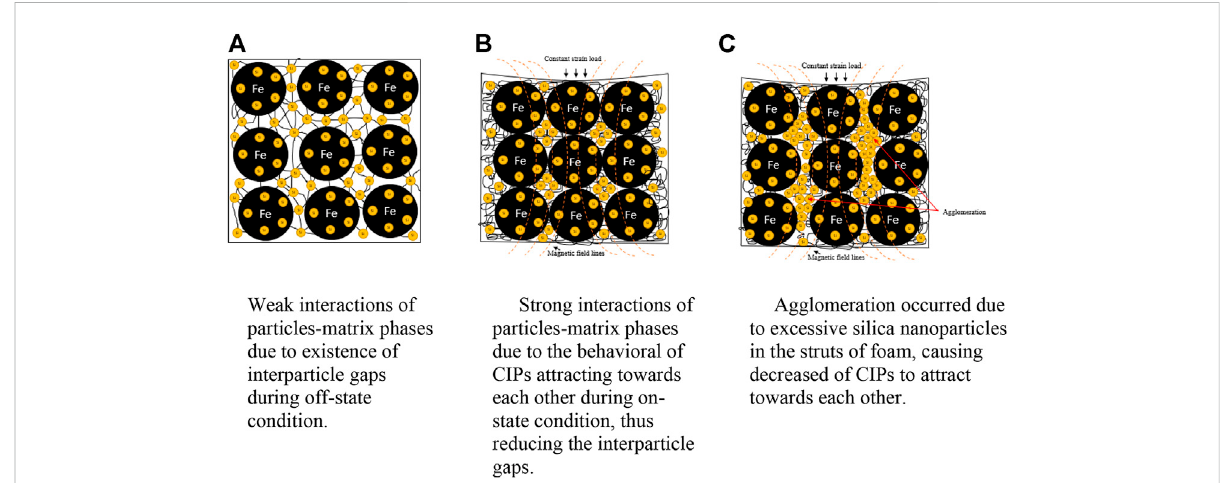
FIGURE 4 Schematic illustration of particles – matrix interactions in MR foam, at off- and on-state conditions. (A) Weak interactions of particles – matrix phases due to existence of interparticle gaps during the off-state condition. (B) Strong interactions of particles – matrix phases due to the behavioral of CIPs attracting toward each other during the on-state condition, thus reducing the interparticle gaps, (C) Agglomeration occurred due to excessive silica nanoparticles in the struts of foam, causing decrease of CIPs to attract toward each